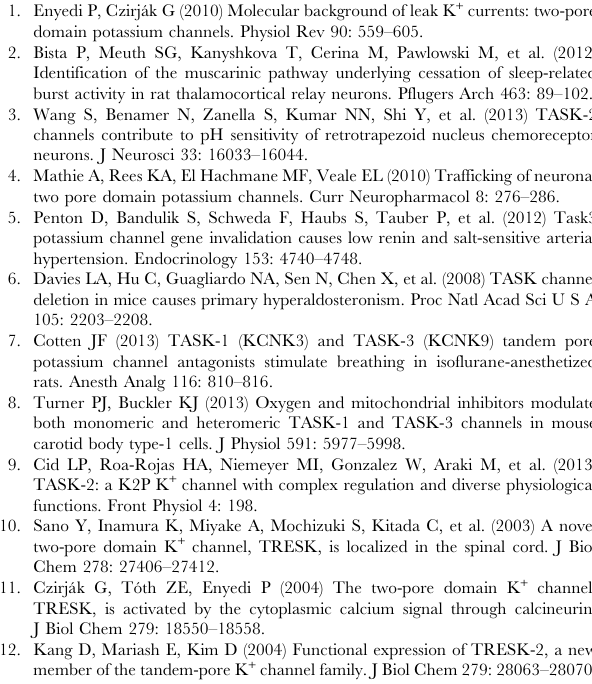
much less with the chromatographic resin ( lane 1 ) or GST ( lane 2 ).